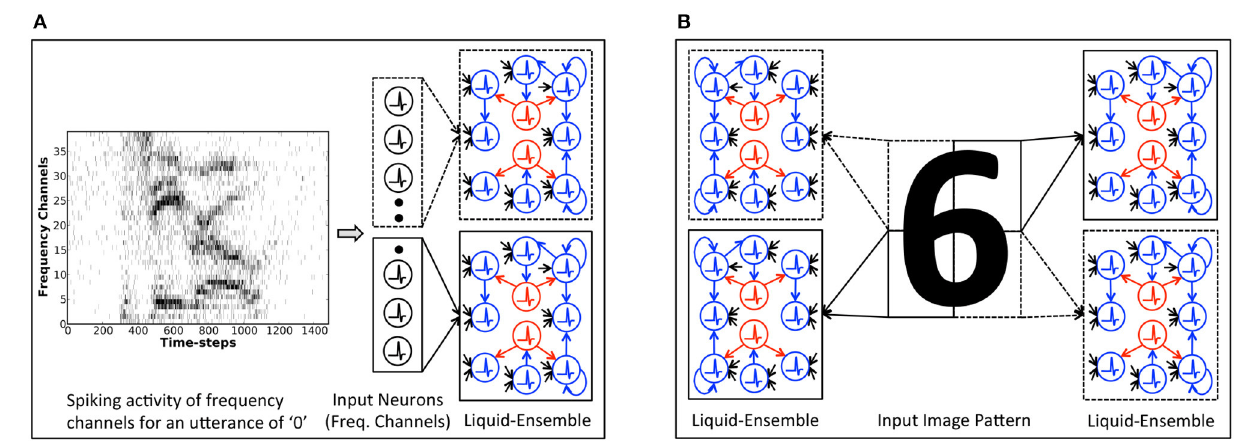
FIGURE 3 | Illustration of the Spiking Liquid-Ensemble Computing (SpiLinC) architecture composed of a distributed arrangement of multiple liquids operating in parallel. (A) Two-liquid SpiLinC, where each liquid constituting the ensemble is trained with different frequency channels of a speech signal (utterance of “0” in this example). (B) Four-liquid SpiLinC, where the individual liquids are trained with separate partitions of an image pattern.